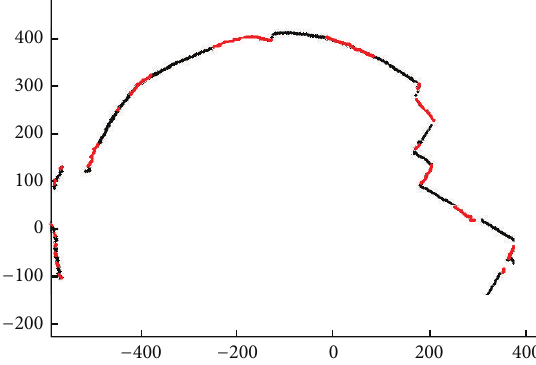
Figure 3: Blur segment.